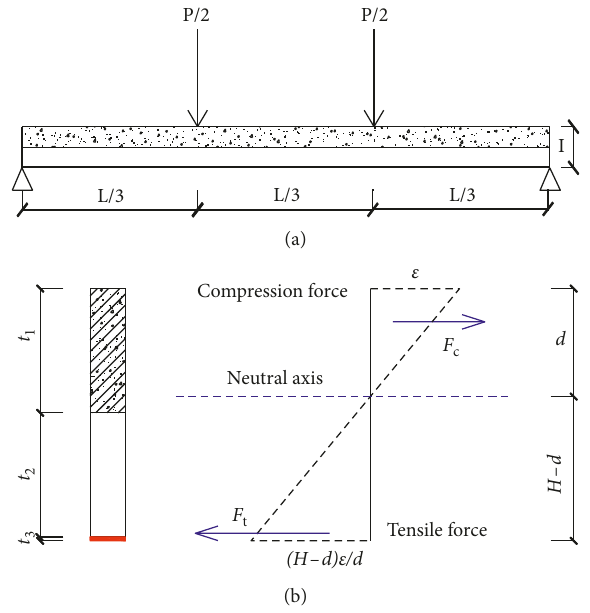
Figure 9: Force diagram: (a) schematic illustration the loading; (b) forces for cross